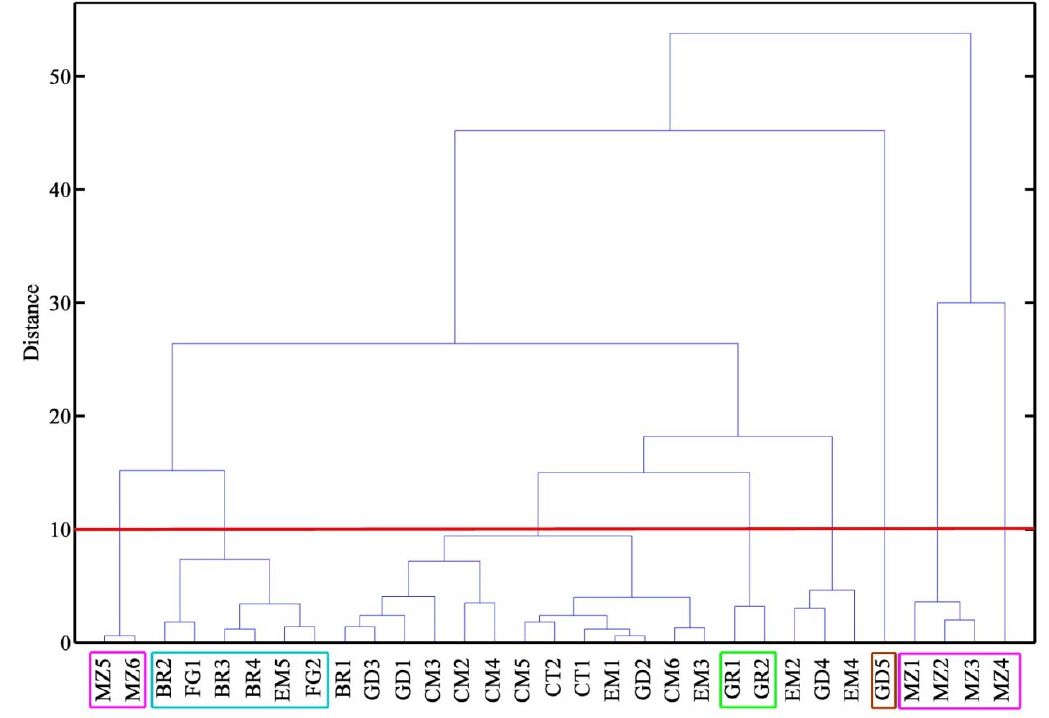
Figure 6. Dendrogram based on Chebyshev distance and complete linkage, applied to data obtained with sensor 10 and sensor